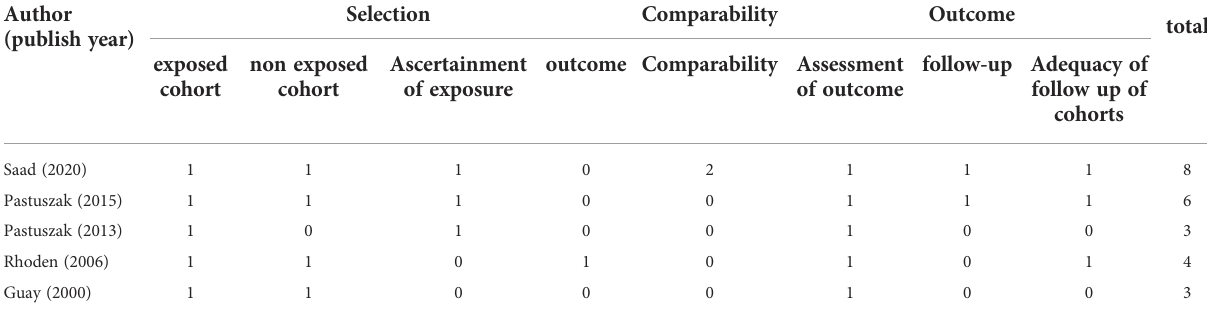
TABLE 3 Quality assessment of individual cohort